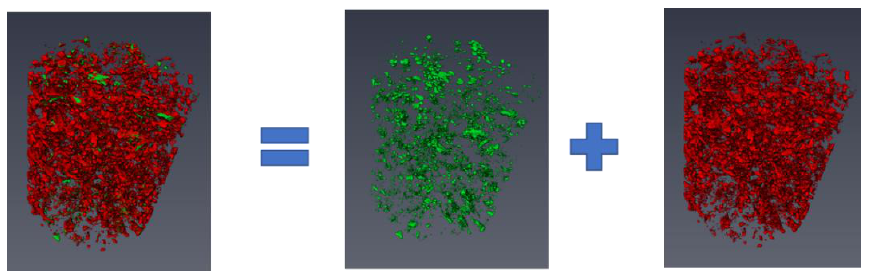
Figure 11. The rock sample after water flooding (green is the injected water and red is the remaining oil after water flooding).